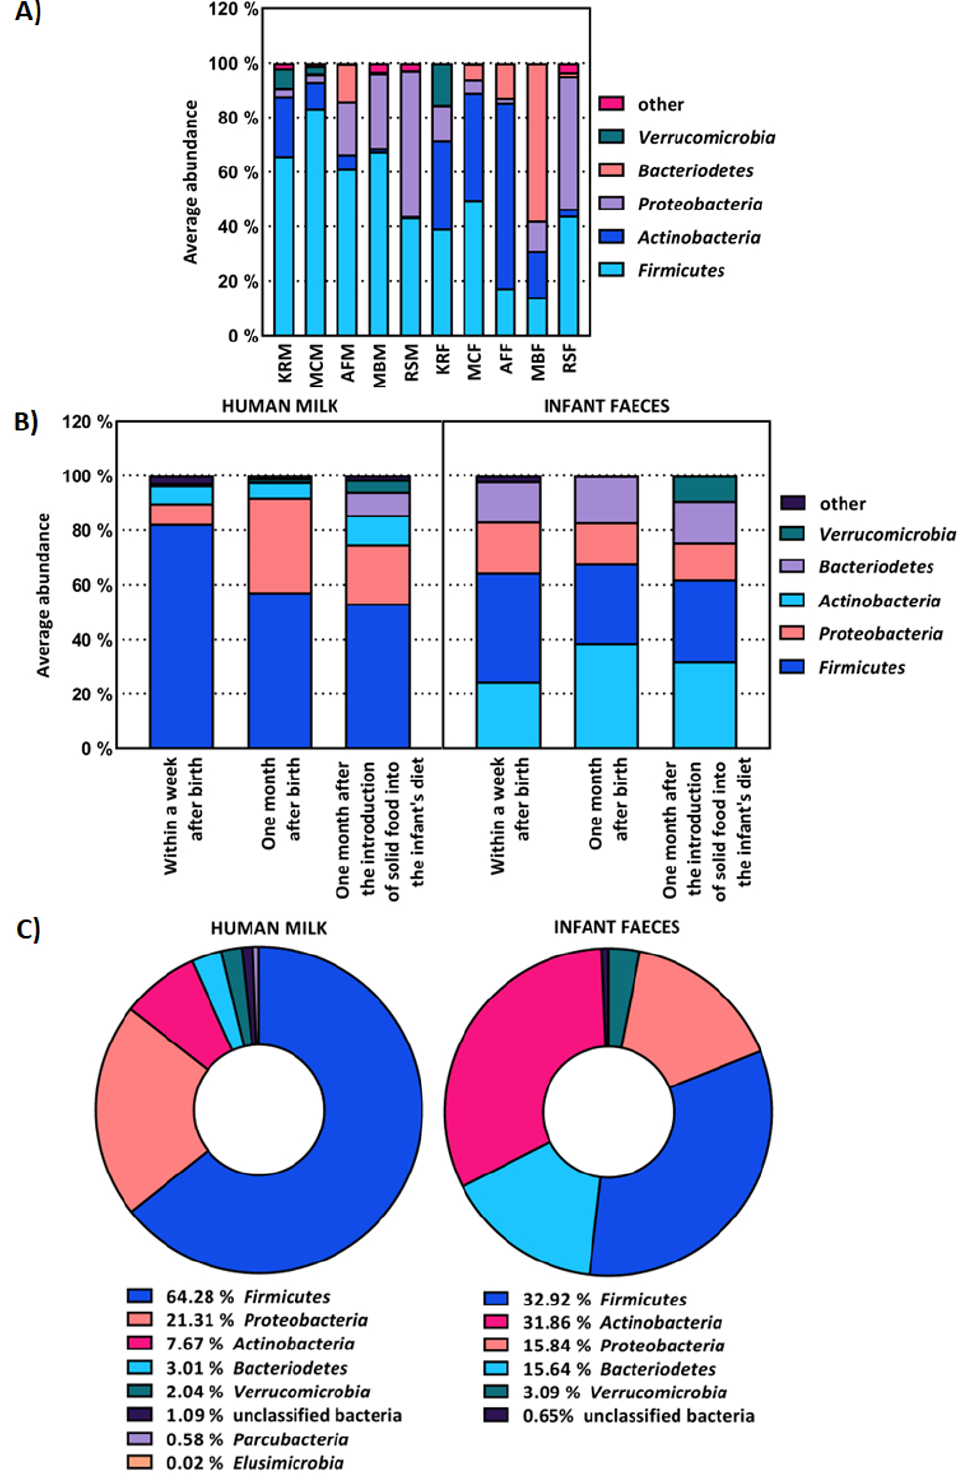
Figure 1. Average abundance of operational taxonomic units (OTUs) at phylum level of: ( A ) human milk samples from the same mother (M), i.e., faeces (F) from the same infant, ( B ) all human milk and infant faeces samples collected within one week and one month after birth, and one month after the introduction of solid food into the infant’s diet, ( C ) all human milk and infant faeces samples. OTUs with an average representation of less than 2% are classified as